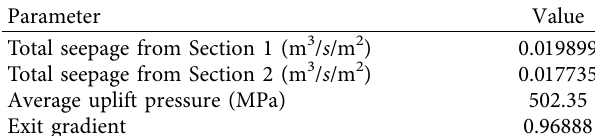
Table 4: The values of the parameters in the initial state.